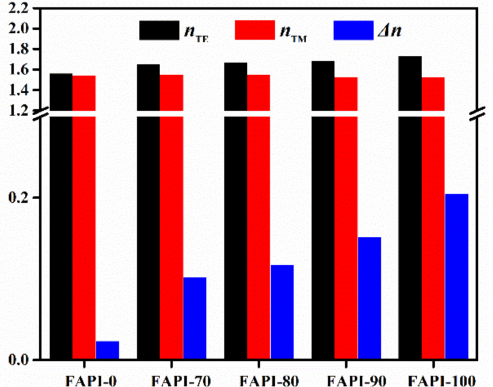
Figure 10. Birefringence index of the FAPI films with different biphenyl content in polymer backbone.